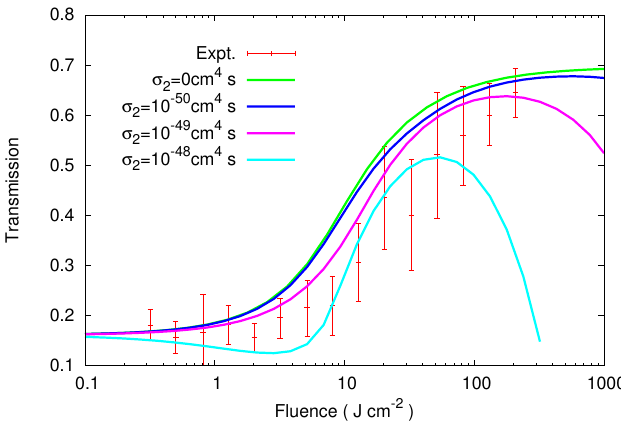
Figure 3. Transmission for Al thin film (53 nm) with two photon absorption (TPA) model at 92 eV photon energy of X-ray pulse, compared with experimental data (Expt.). Four different TPA cross sections—0, 10 − 50 , 10 − 49 and 10 − 48 cm 4 s—are used to demonstrate a non-linear optical effect.